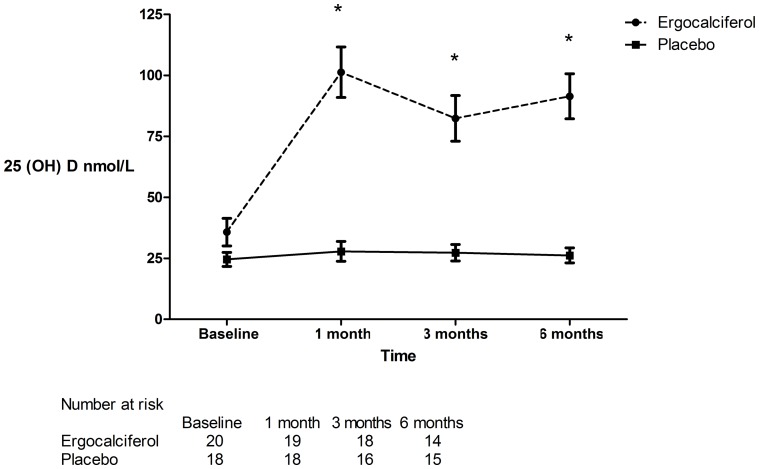
25 (OH) D levels in patients treated with ergocalciferol and placebo.Bonferroni post tests following two way repeated measures ANOVA at 1,3 and 6 months p<0.0001. (*  =  statistically significant).